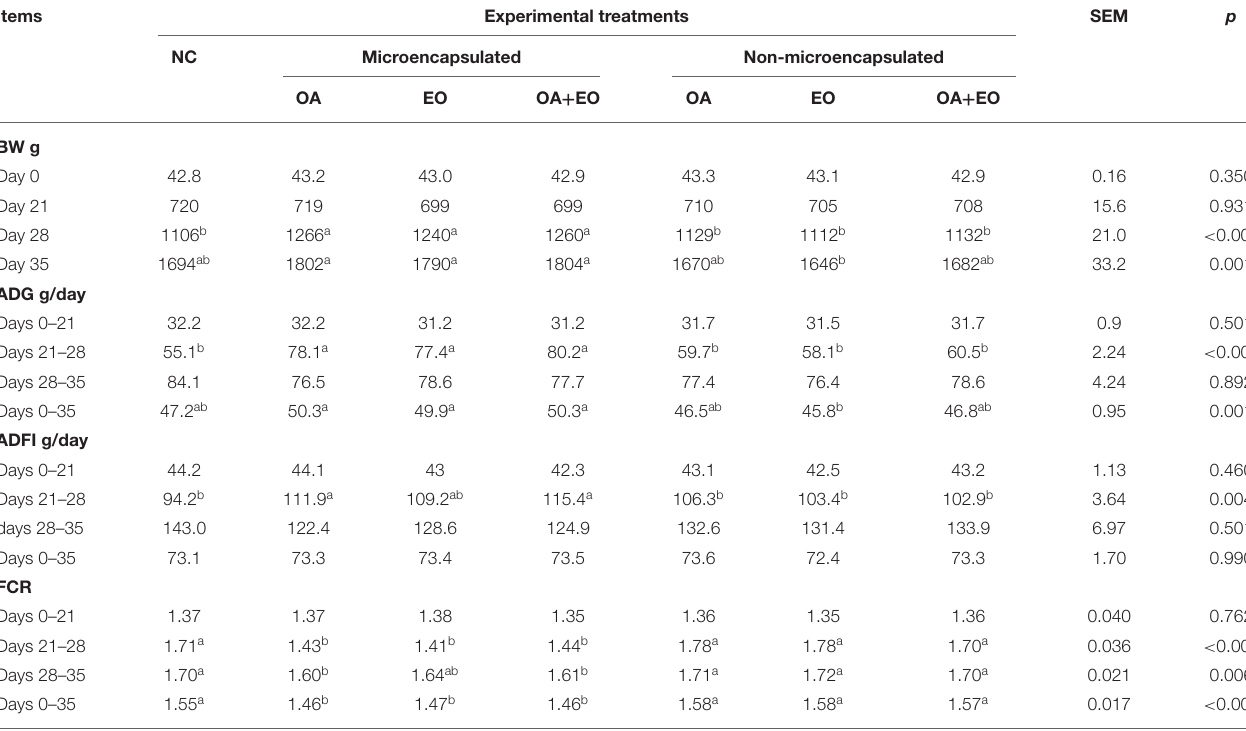
TABLE 2 | Effect of dietary treatments on growth performance of broiler chickens.